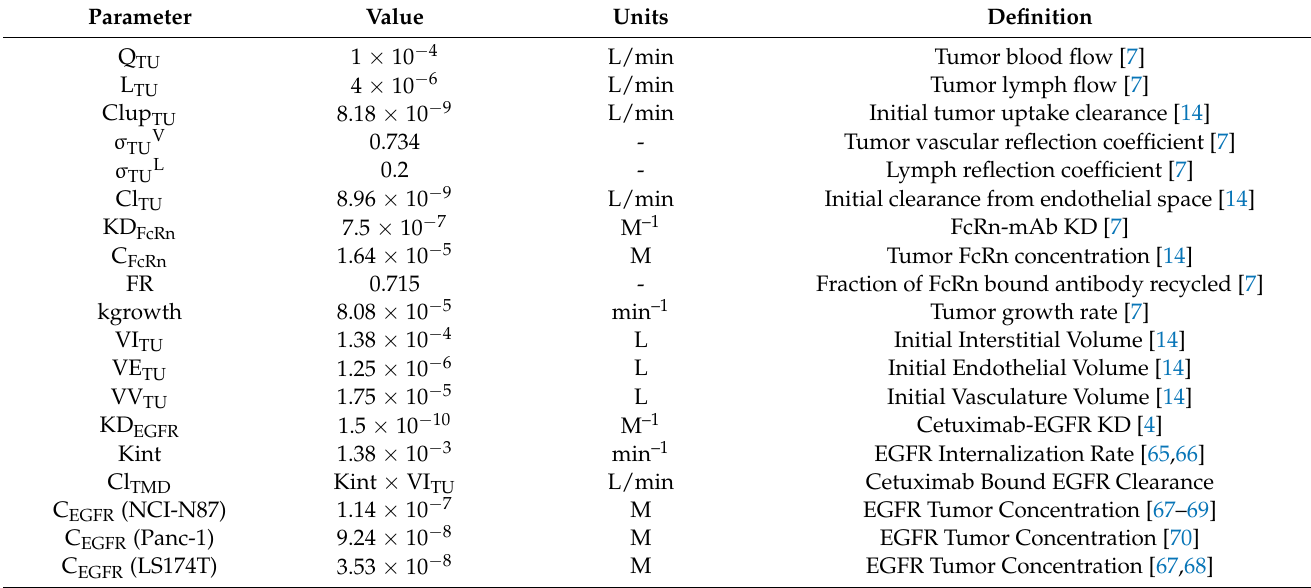
Table 2. PBPK Model Tumor Parameter Values and